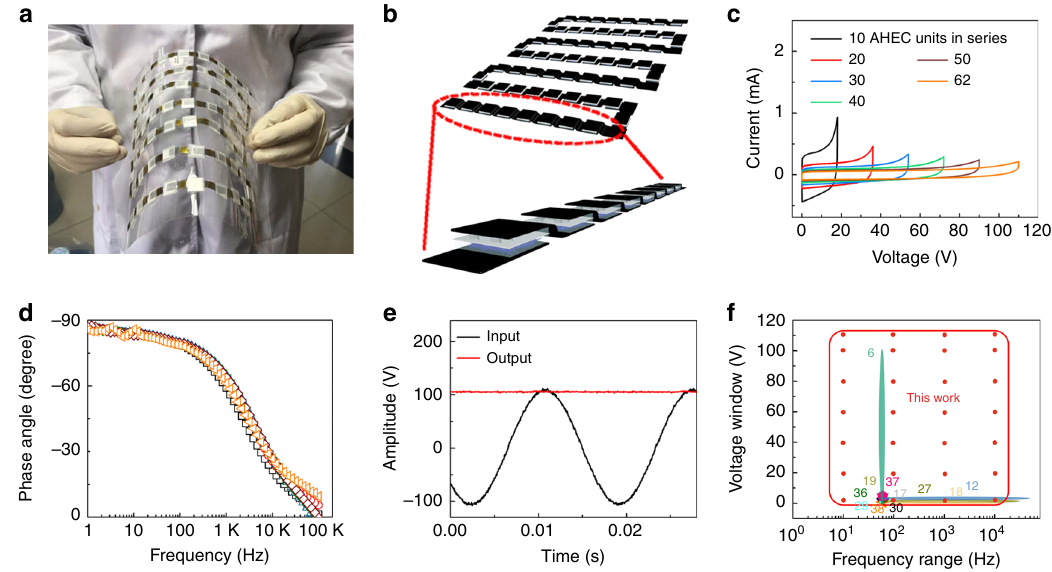
Fig. 6 The electrochemical performances of integrated units. a , b Photograph ( a ) and schematic illustrations ( b ) of fl exible 62 aqueous hybrid electrochemical capacitor (AHEC) units connected in series. c CV curves for different numbers of AHECs connected in series (scan rate: 10 V s − 1 ). d Plots of phase angle versus frequency of different numbers of AHECs connected in series. e AC line- fi ltering performances of 62 AHEC units connected in series. f Comparison of the voltage window and frequency demonstration of the AHECs with those of the reported AC-line fi ltering ECs, the red curves and circles represent the voltage and frequency range in this work (Supplementary Table 2) 6,12,17 – 19,27,29,30,36 – 38 . Source data are provided as a Source Data fi